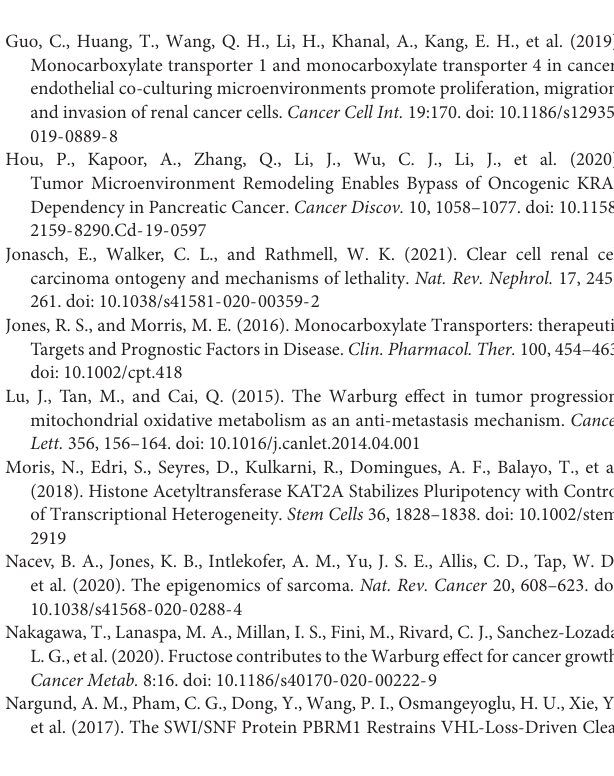
Supplementary Figure 1 | KAT2A was a risk factor in RCC. (A) KAT2A expression levels correlated with higher tumor grades and T stages. (B) The ROC curve indicating the predictive efficiency of KAT2A in the TCGA-KIRC cohort. Supplementary Figure 2 | KAT2A promoted the tumor growth of RCC. (A) The protein levels of KAT2A in Caki-2 cells with KAT2A overexpression or deficiency were validated via Western blotting. (B) KAT2A deficiency significantly inhibited tumor weight. Supplementary Figure 3 | KAT2A correlated with its downstream target of MCT1. (A) The expression levels of KAT2A correlated positively with MCT1 in the TCGA-KIRC cohort. (B) Kaplan-Meier analysis suggested that patients with a high MCT1 suffered from worse overall survival (OS) outcomes compared with those with a low MCT1 (Log-rank test P < 0.001). (C) The extracellular acidification rate (ECAR) kinetic profiles indicated that the glycolytic activity of Caki-2 cells could be significantly impaired with KAT2A